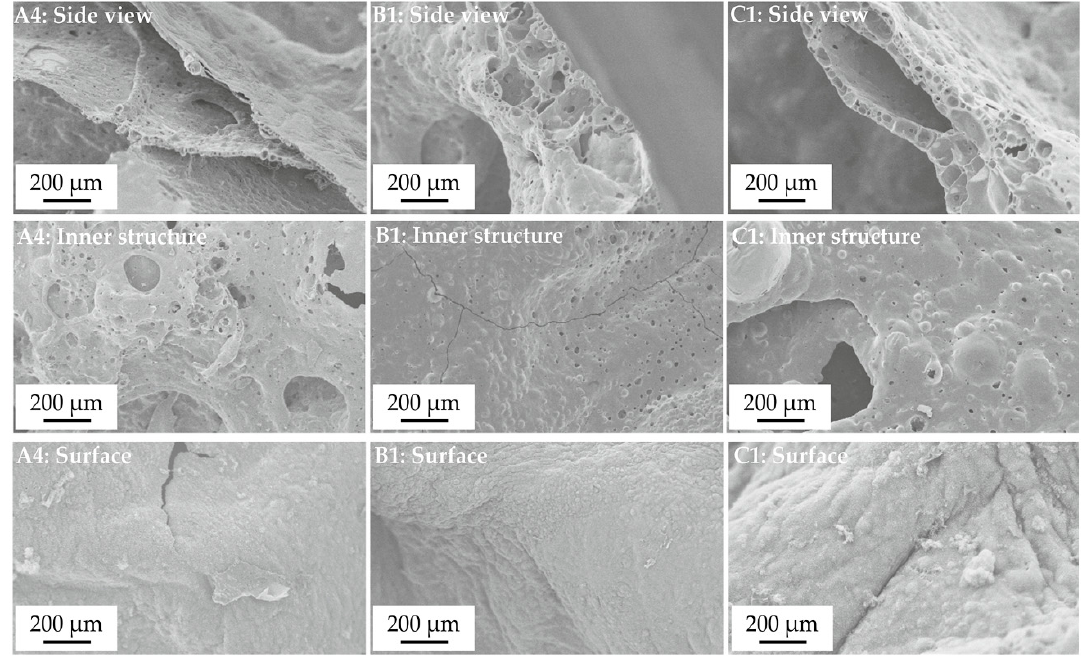
Figure 10. Morphology of the fire residues of A4 , B1 , and C1 . Scanning electron microscope (SEM): side view to get a cross-section of the top of the residue, inner structure and surface top view.